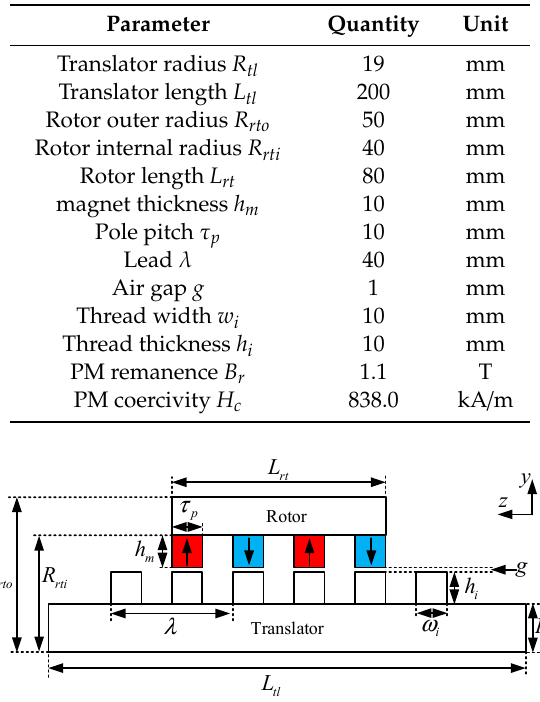
Figure 5. Physical meaning of the parameters shown in Table 1.